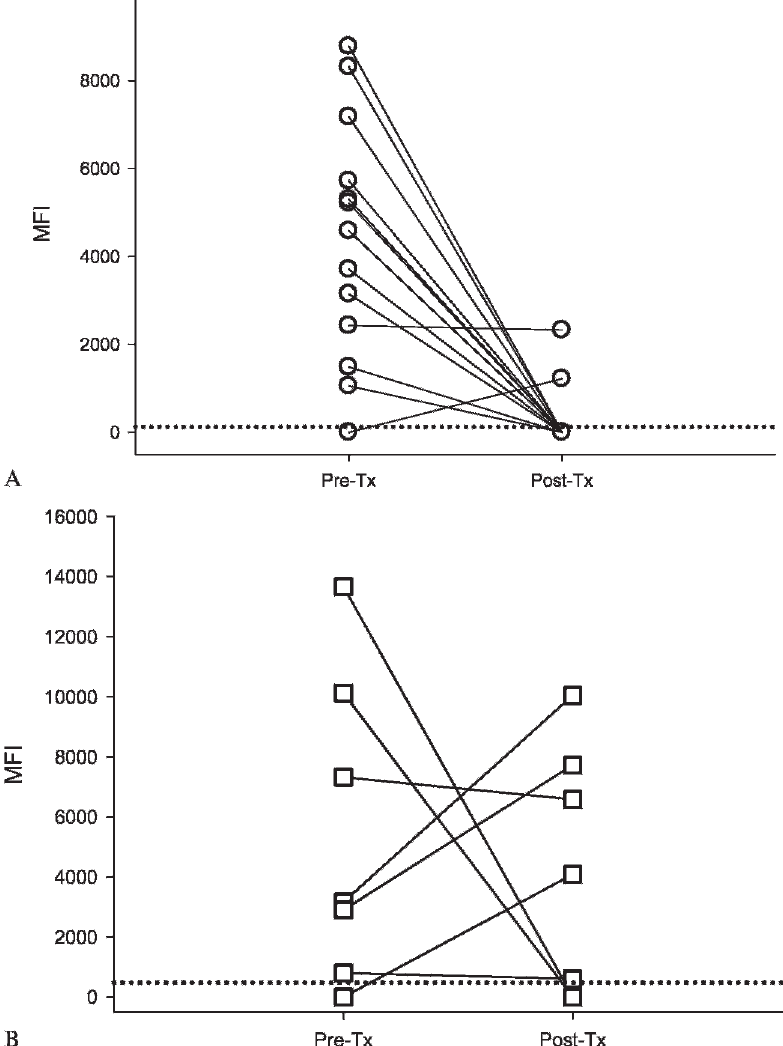
Figure 1 - Pre- and posttransplant MFIs of each of the detected DSAs in 11 patients who remained active until the last follow-up visit (figure 1a) and in 5 patients who lost their allografts or died (figure 1b). The dotted line represents the standard cut-off MFI value for